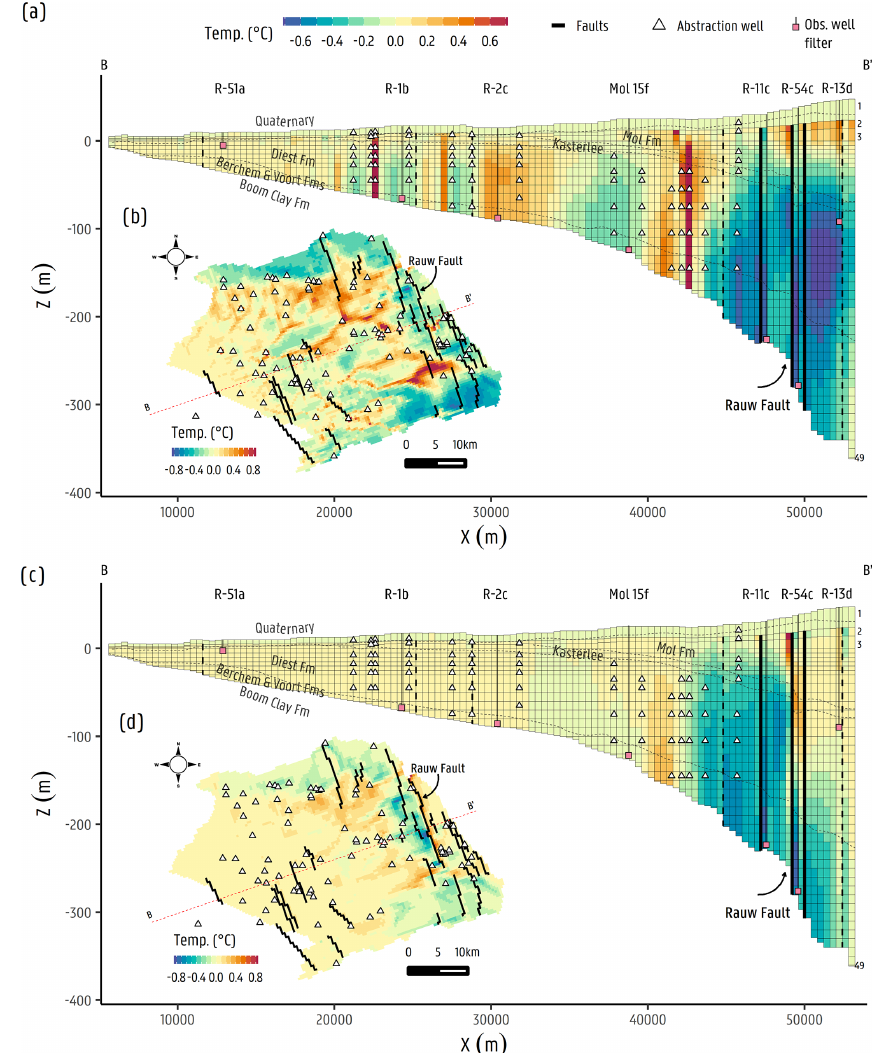
Figure 9. Cross sections and plan view (model layer 10) showing the differences between the baseline model minus both cases, with panels (a, b) for the thermal conduction only case and panels (c, d) for the temperature distribution without